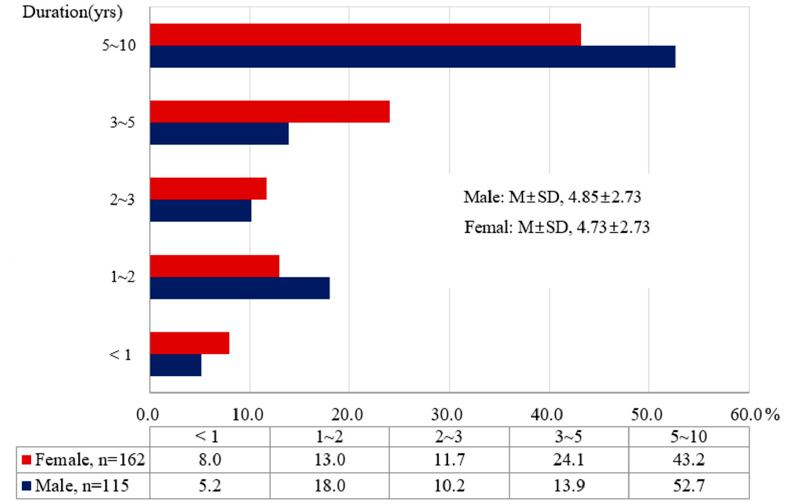
Figure 2. Duration of developing heart failure after ischemic heart disease.